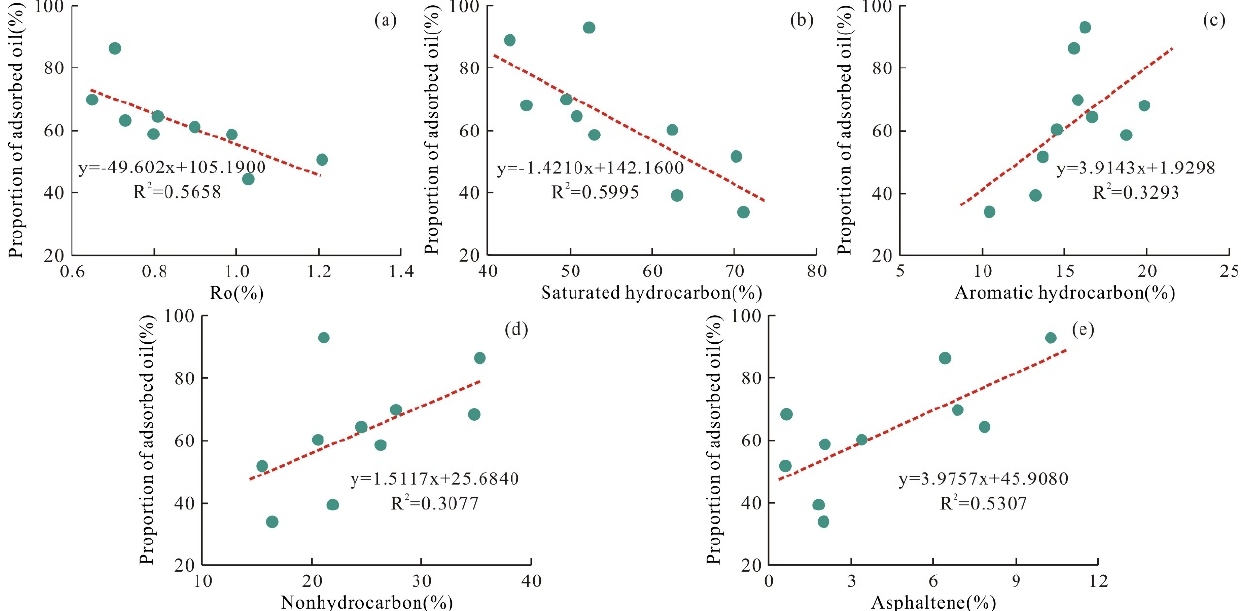
Figure 13. Correlations ( a ) between the proportion of adsorbed oil and Ro and ( b – e ) between the proportion of adsorbed oil and shale oil component.